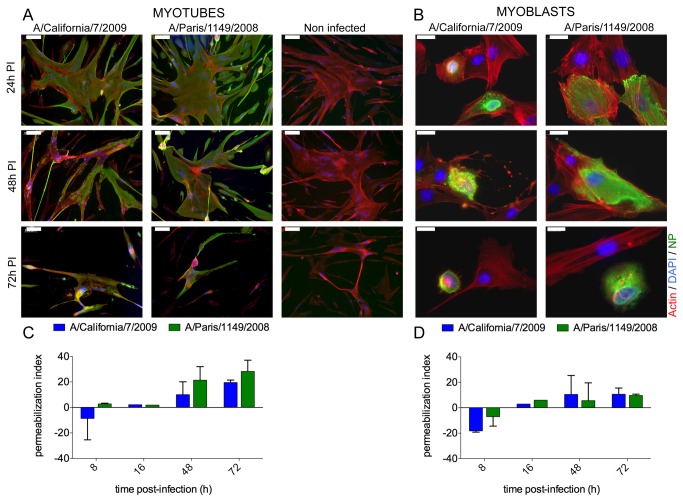
Muscle cell death and lysis after infection by influenza A(H1N1).
A, B. The morphology of the actin cytoskeleton (red) of myotubes and myoblasts (donor CHQ) was observed by immunofluorescence at various time points after infection by the A/California/7/2009 or A/Paris/1149/2008 isolate and in non-infected cultures grown in parallel. The nucleoprotein NP (green) was used to discriminate between infected and non-infected cells, and DAPI was used to stain the nucleus. Bars: A, 100µm, B, 20µm.
C, D. The concentration of lactate dehydrogenase (LDH) released in the culture supernatants was measured by an enzymatic assay at various time points after infection by the A/California/7/2009 or the A/Paris/1149/2008 isolate. This concentration was normalized using untreated and chemically-permeabilized non-infected cultures to calculate a rate of LDH release reflecting the index of cell permeabilization. Results are expressed as the mean and SD of two independent experiments on CHQ cells.